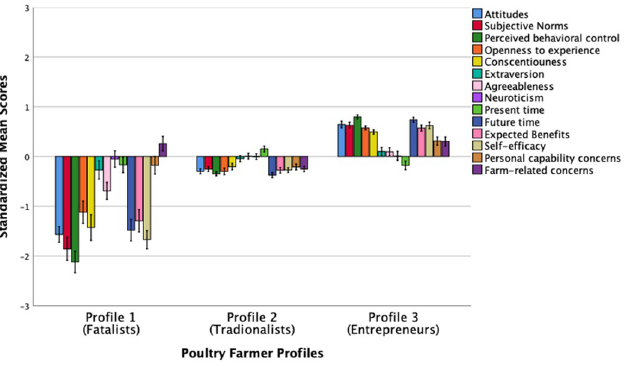
Fig 2. Standardized mean scores ( M = 0, SD = 1) of different psychological characteristics across three poultry farmer profiles. Error bars represent standard errors (SE) ± 1.